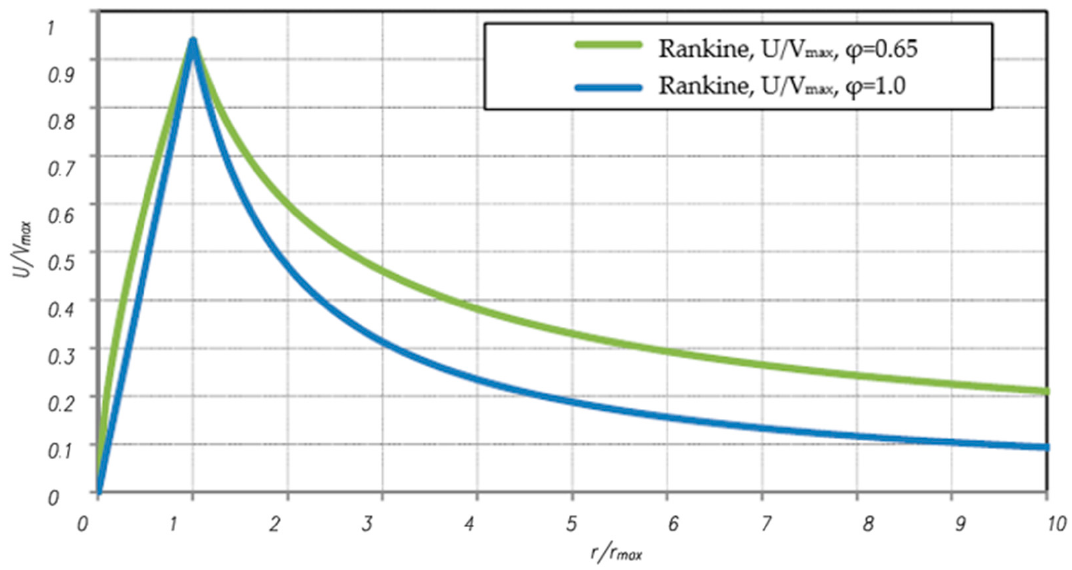
Figure 2. Rankine model’s component of radial velocity.